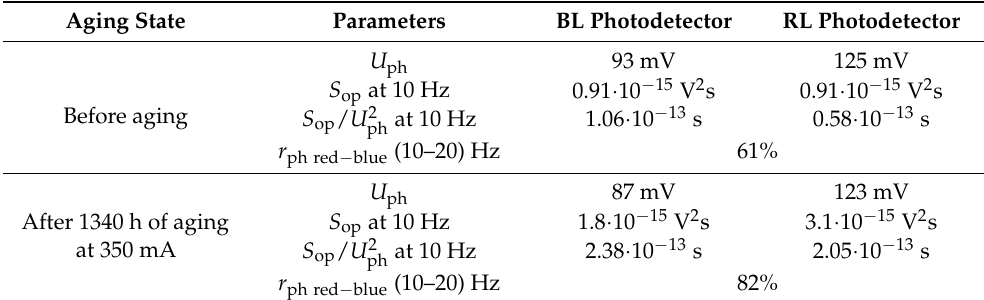
Figure 13. Optical noise spectra measured by ( a ) BL and ( b ) RL photodetectors at 140 mA forward current before aging (solid lines) and after 1340 h aging (dash lines) at 350 mA. Table 2. Summary of the 1 W white InGaN LED the optical noise measurements by BL and RL photodetectors at 140 mA forward current.